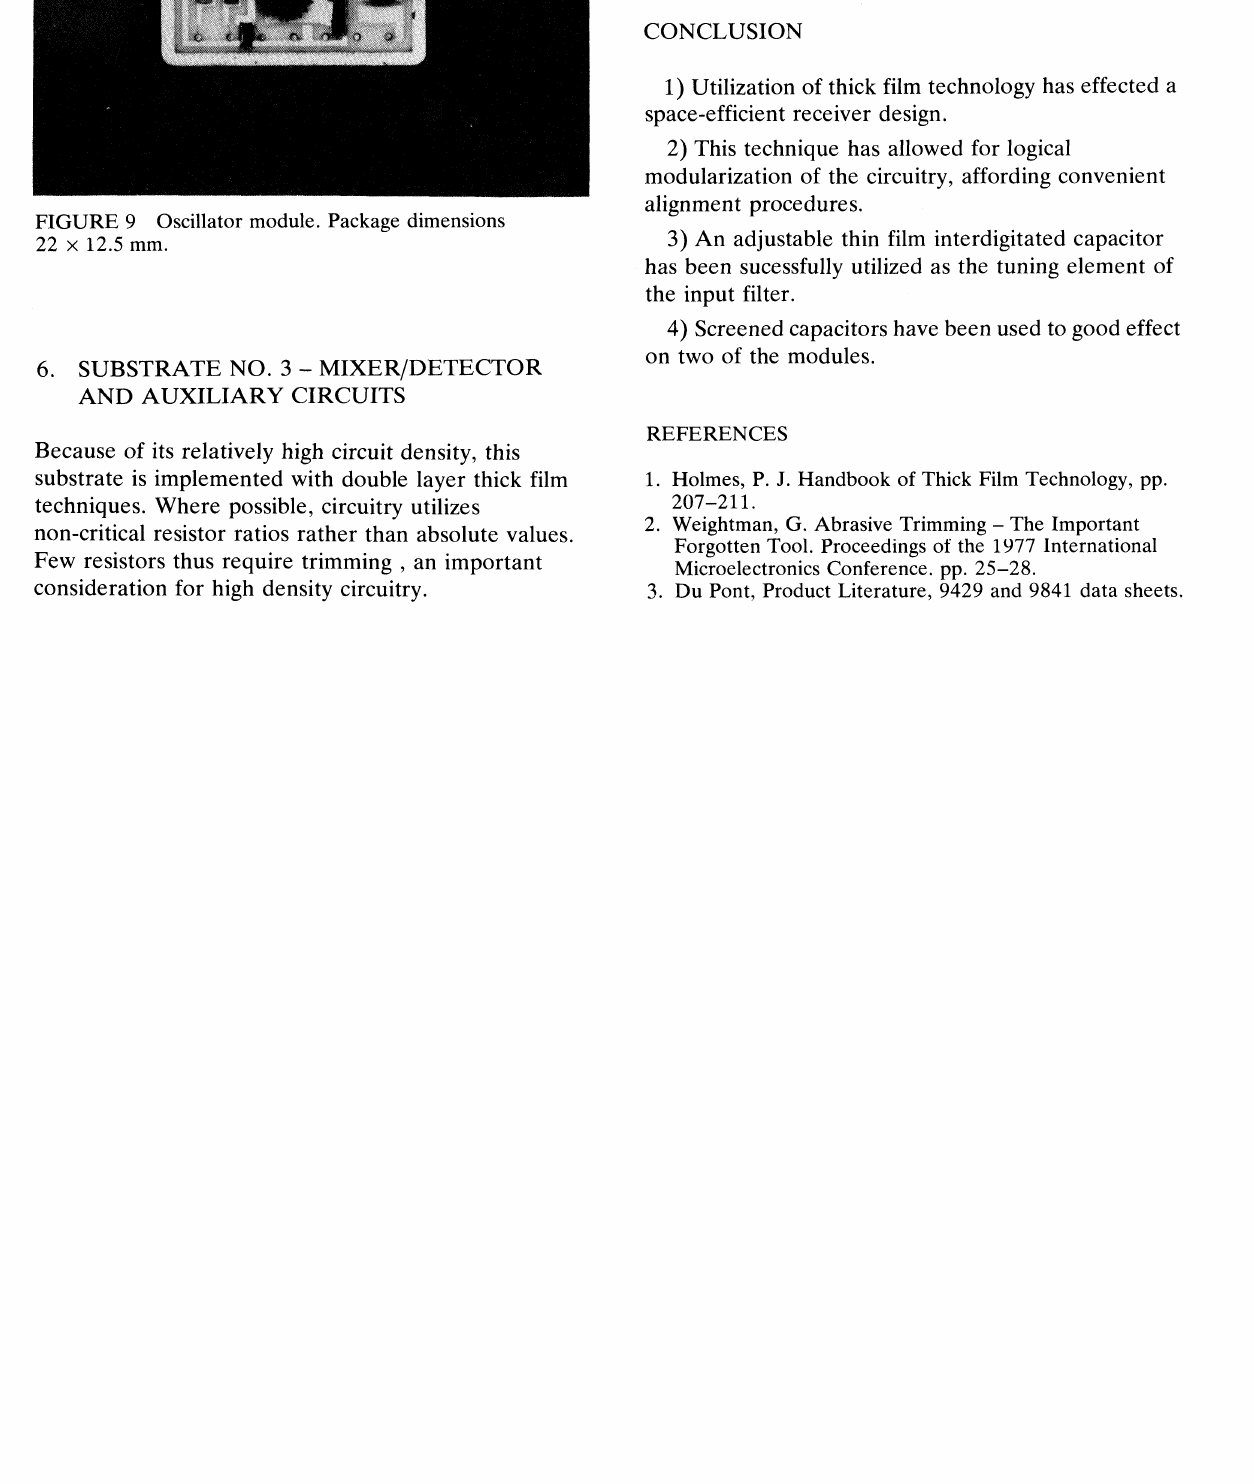
FIGURE 9 Oscillator module. Package dimensions 22 x 12.5